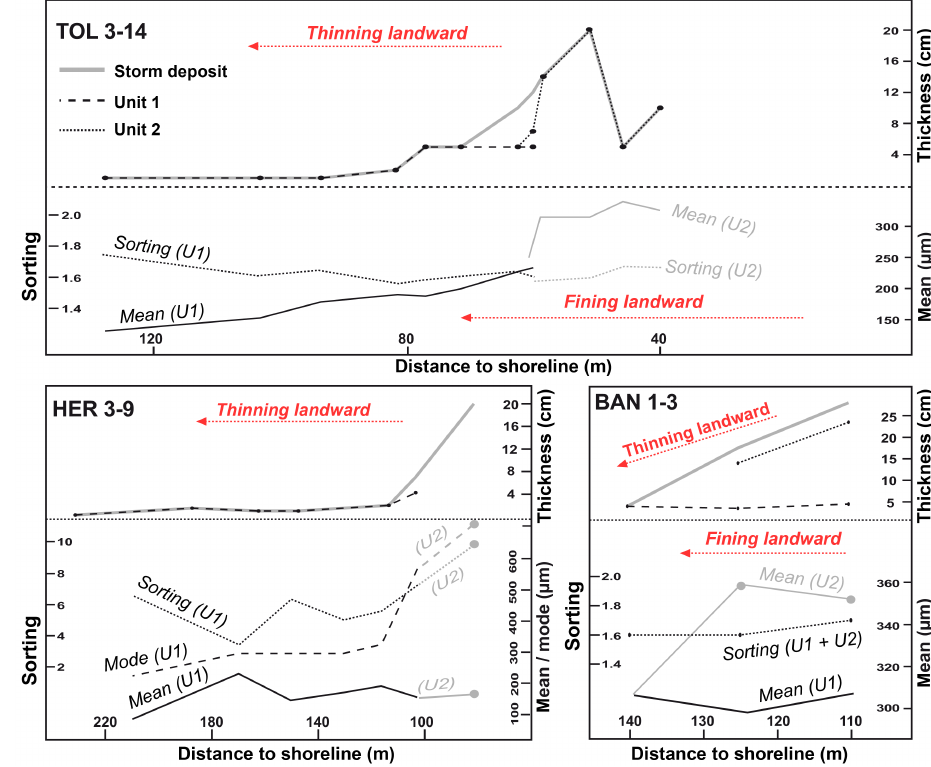
Figure 3. Landward trends of grain size and thickness in typhoon deposits. Onshore deposits at sites TOL, HER, and BAN B tend to thin landward. While the deposits at HER and BAN are also characterized by fining trends of the mean grain size, a monotonic landward fining is not observed at TOL. Clear trends in sorting are not detected at all sites. Note the different